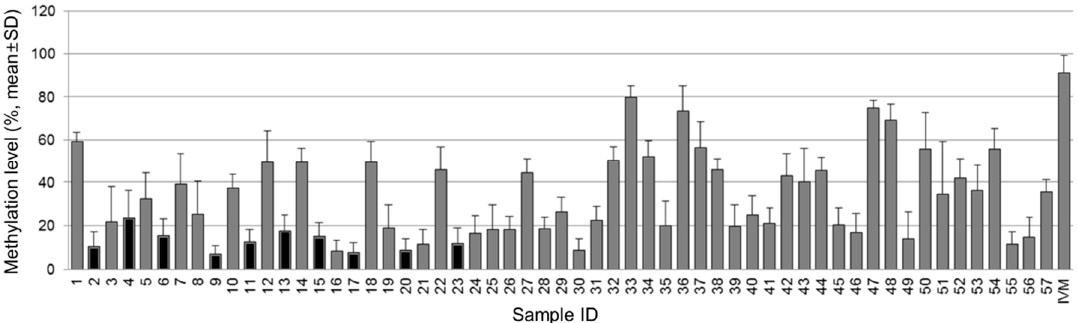
Figure 2. Pyrosequencing data of the NT5E gene. Gray box indicates methylation level of the NT5E gene in tumor tissue and black box indicates that of normal tissues.